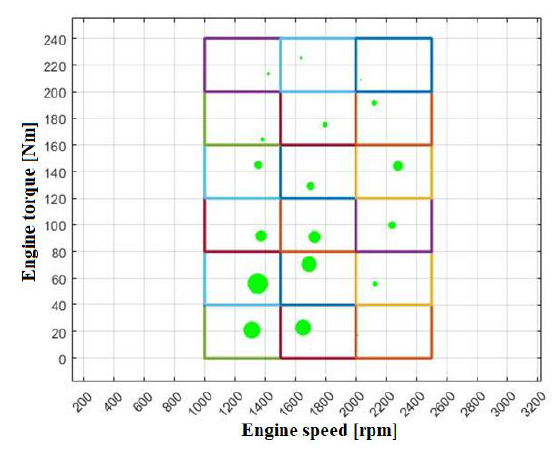
Fig. 8. Binned engine operation points under WLTC 3b